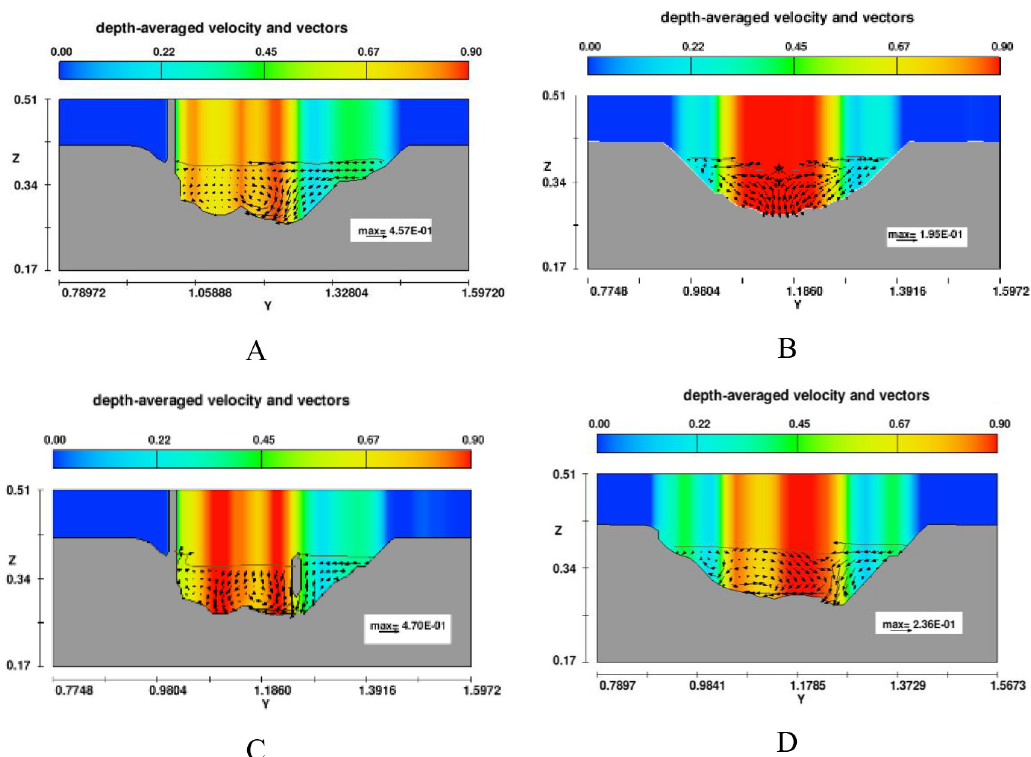
Fig 14. Depth-averaged velocity distributions in section